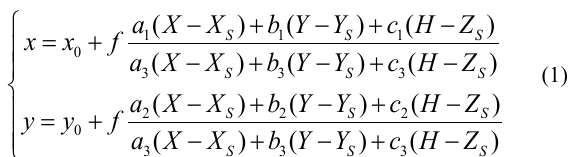
Figure 3. Diagram of module